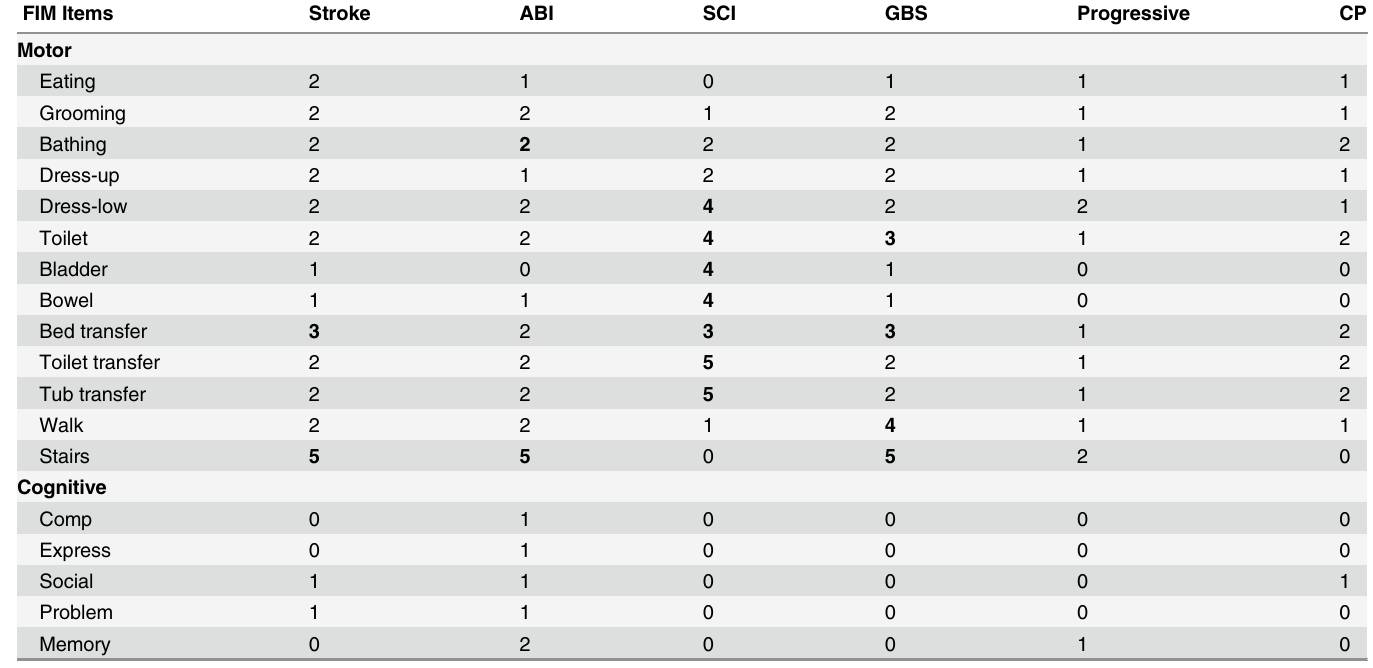
Table 6. Improvement in the median FIM item scores between admission and